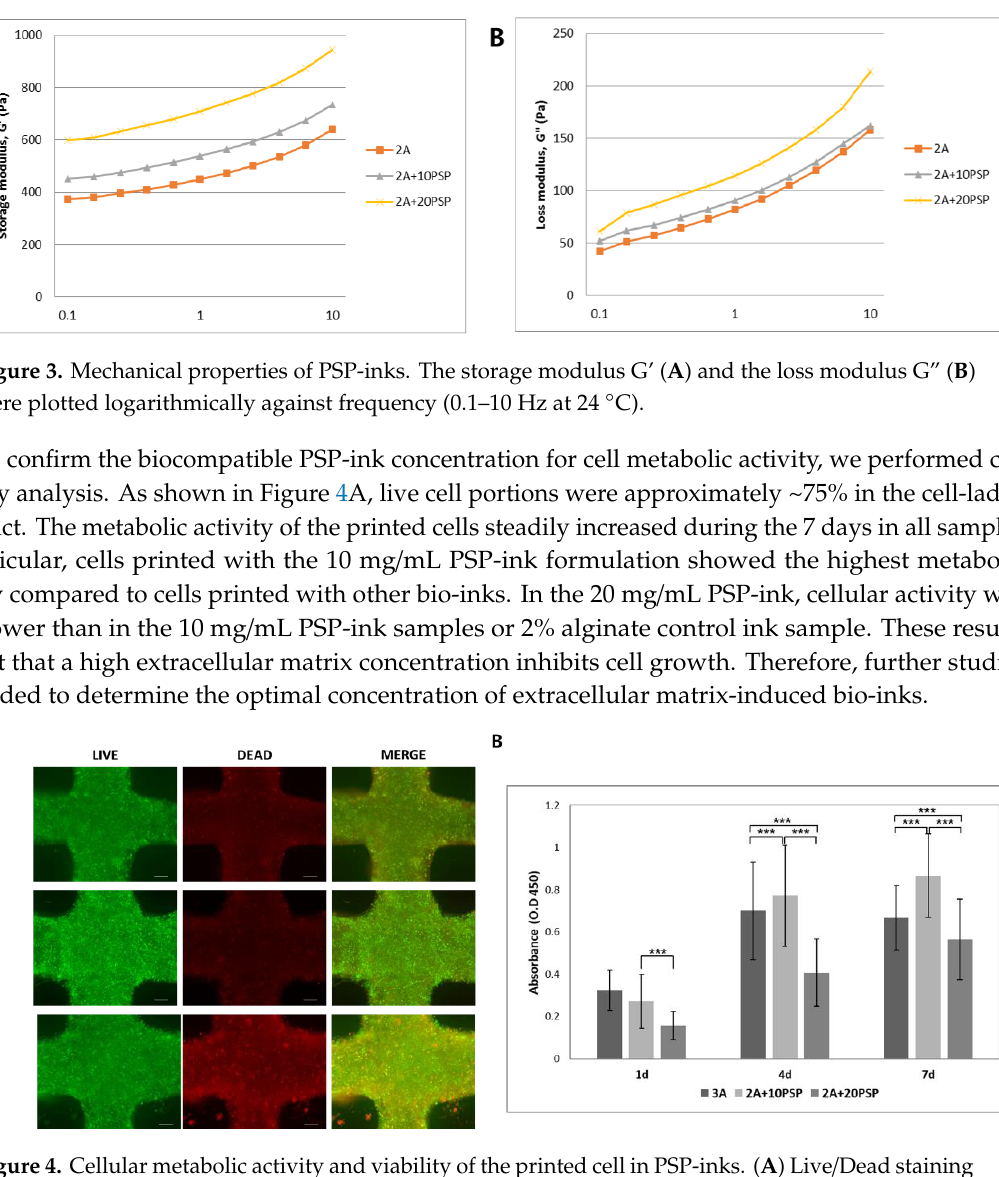
Figure 4. Cellular metabolic activity and viability of the printed cell in PSP-inks. ( A ) Live/Dead staining fluorescence image. Scale bars are 200 μm. ( B ) WST-1 assay results of printed cells in PSP-inks after 7 days of incubation. The statistical significance of differences between the 3% alginate hydrogel (3A) and PSP-inks in 2% alginate (2A+10PSP, 2A_20PSP) groups were assessed using one-way ANOVA with Tukey ’ s post hoc test. *** p < 0.001.